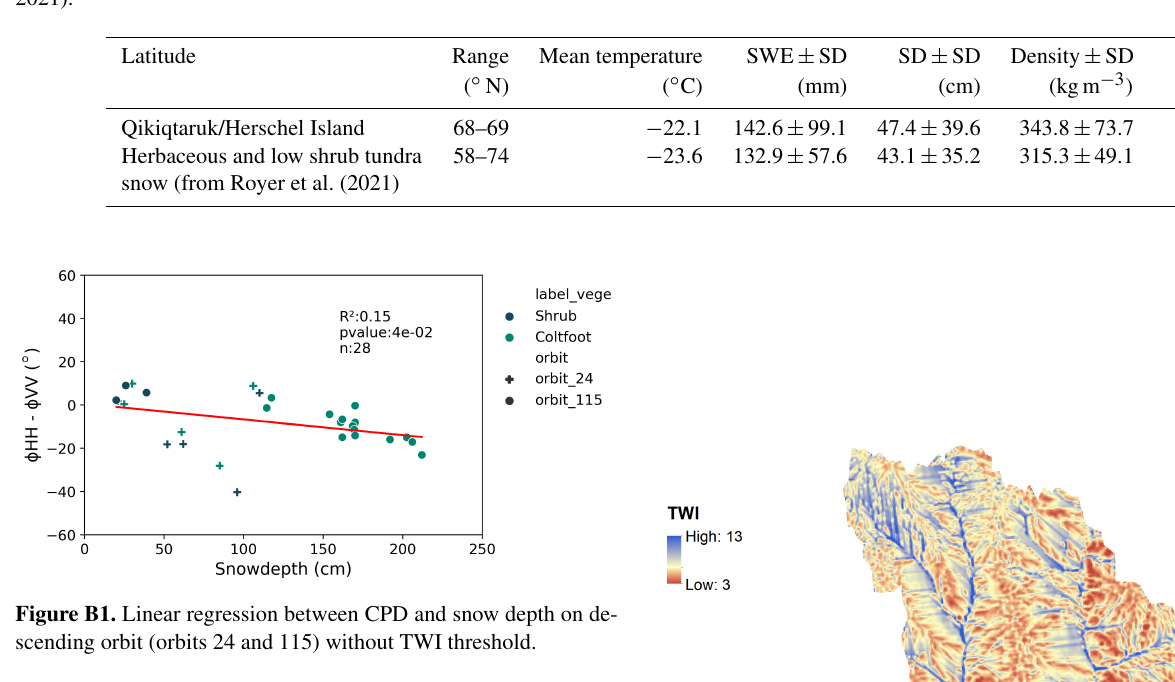
Table B2. Comparison of snow characteristics with the Royer et al. (2021) classification. Mean temperature was extracted from the 1974– 2019 meteorological station from Qikiqtaruk/Herschel Island and for the winter season (December to March as defined by Royer et al., 2021).